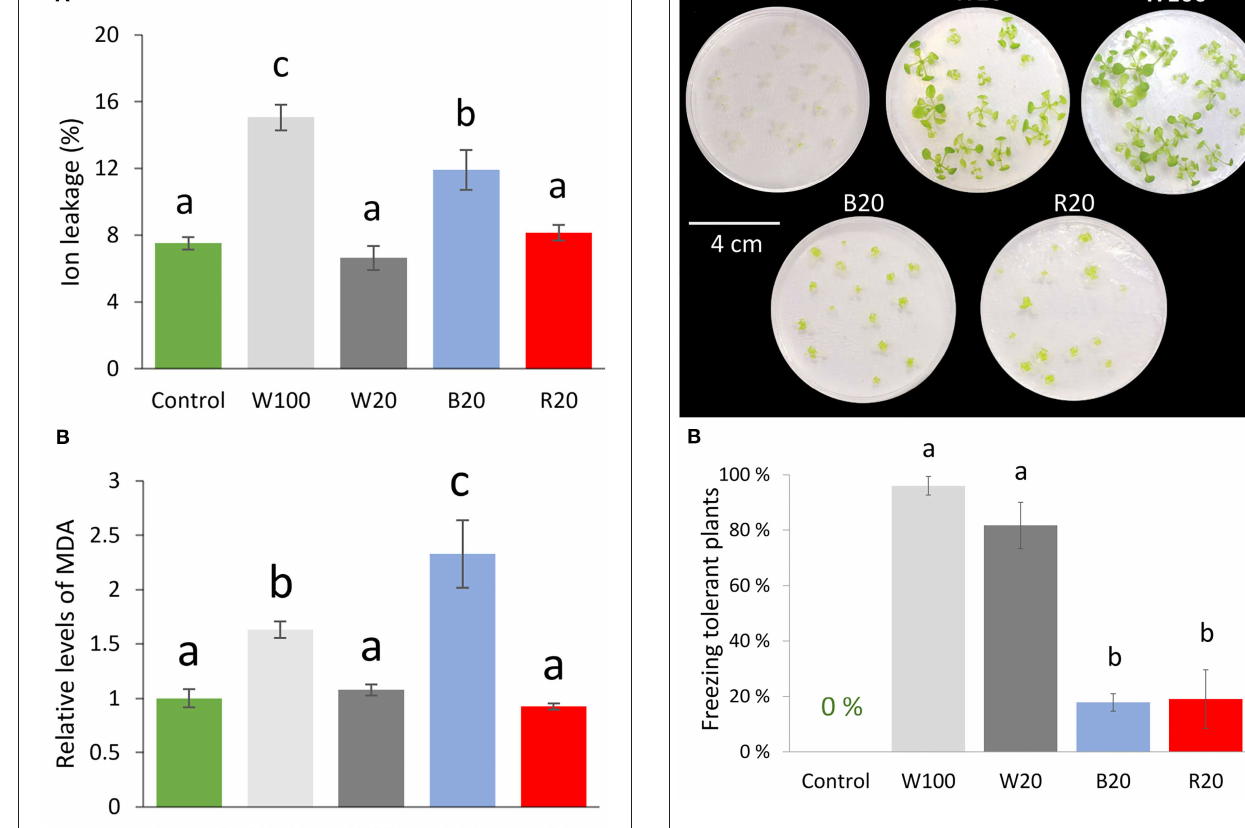
FIGURE 3 | Freezing tolerance of cold-treated plants under different light regimes. (A) Representative images of Arabidopsis Col-0 plants 2 weeks after freezing stress; 2-week-old plants cultivated on Petri dishes in standard conditions were treated at low temperature (4 ◦ C) under different light conditions for a week (W100, W20, B20, R20) and then exposed to freezing stress. Control plants represent 2-week-old plants exposed to freezing stress without the cold treatment. Plants were transferred to control conditions after the freezing stress and recovered for another 2 weeks. (B) Freezing tolerant plants. Plants that produced new leaves were evaluated as freezing tolerant. Results represent means of three biological replicates with standard errors, letters indicate significant differences (ANOVA, Tukey’s HSD post hoc test, p < 0.05). For details, see Materials and